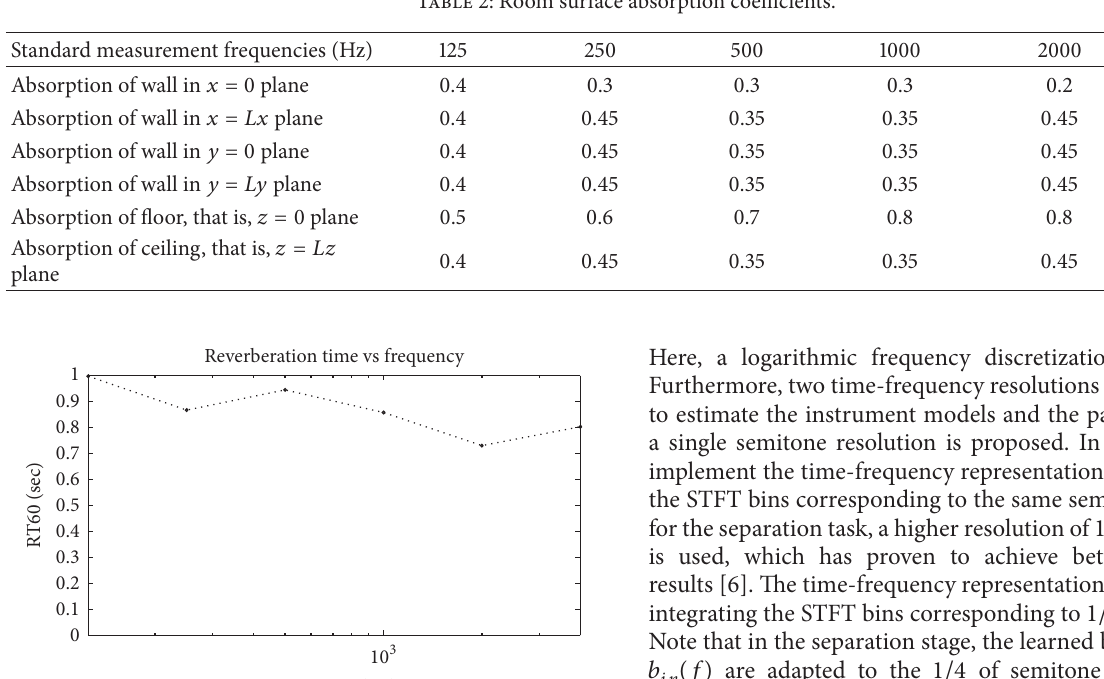
Table 2: Room surface absorption coefficients.